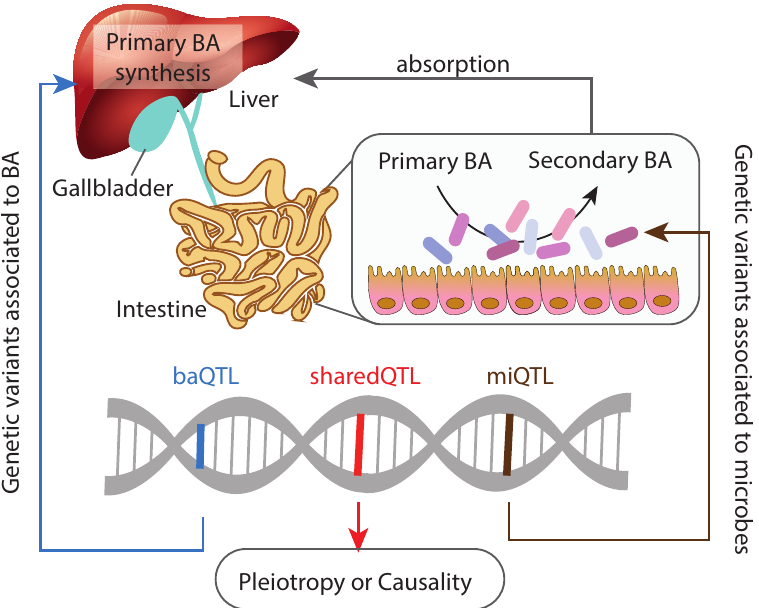
Fig 1. Systems quantitative trait locus (QTL) analysis on gut microbes and BA profiles. baQTL indicates a QTL associated to BA; miQTL indicates a QTL associated to gut microbes; sharedQTL indicates a QTL associated to both BA and gut microbes. BA, bile